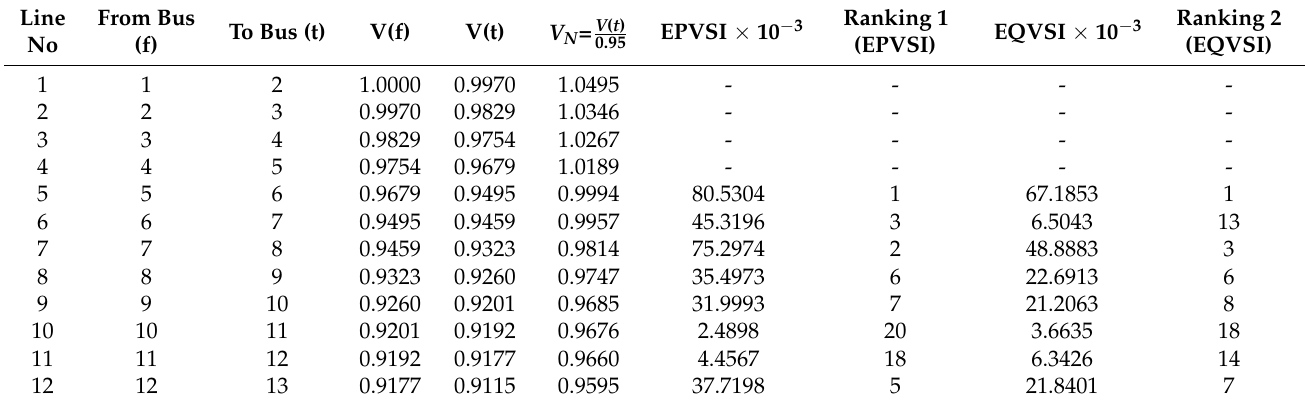
( a ) ( b ) Figure 12. EQVSI values for IEEE ( a ) 33-bus ( b ) 69-bus RDNs. Figure 12. EQVSI values for IEEE ( a ) 33-bus ( b ) 69-bus RDNs. Table 4. Results of EPVSI and EQVSI for IEEE 33-bus RDN. Table 4. Results of EPVSI and EQVSI for IEEE 33-bus RDN. Table 4. Results of EPVSI and EQVSI for IEEE 33-bus